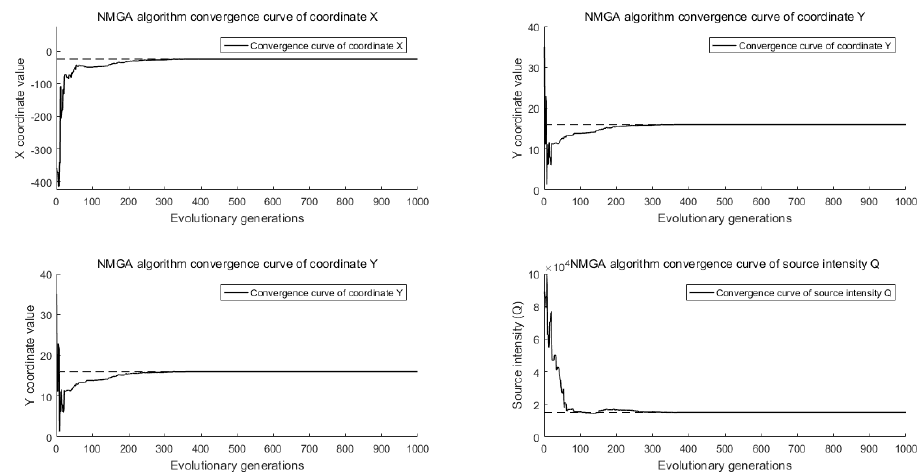
Figure 3. The inverse convergence curves of X, Y, Q, and H e for the NMGA algorithm.